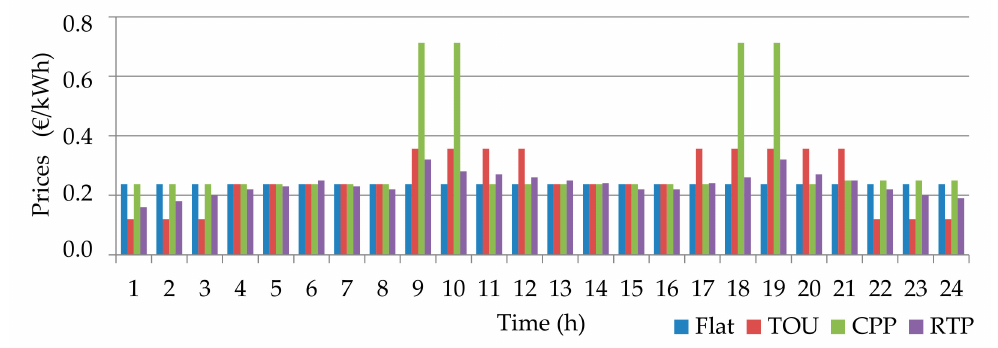
Figure 5. Tari ff s schemes trends